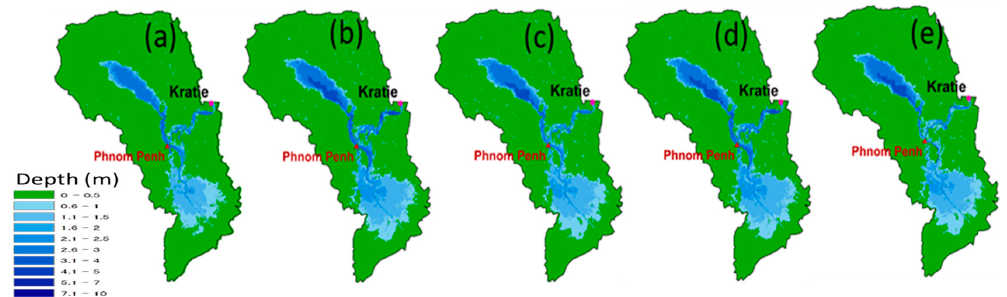
Figure 7. 25-year averaged inundation distributions: ( a ) SPA_m01; ( b ) SFA_rcp85; ( c ) SFA_rcp85-c1; ( d ) SFA_rcp85-c2 and ( e ) SFA_rcp85-c3.